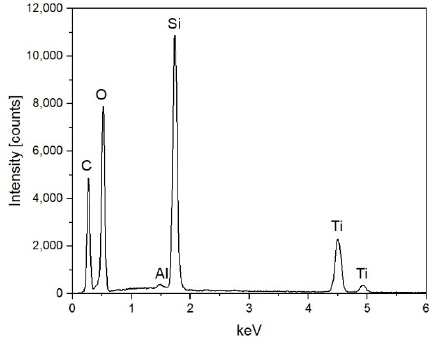
Figure 4. EDX spectrum of Ti-MCM-41.